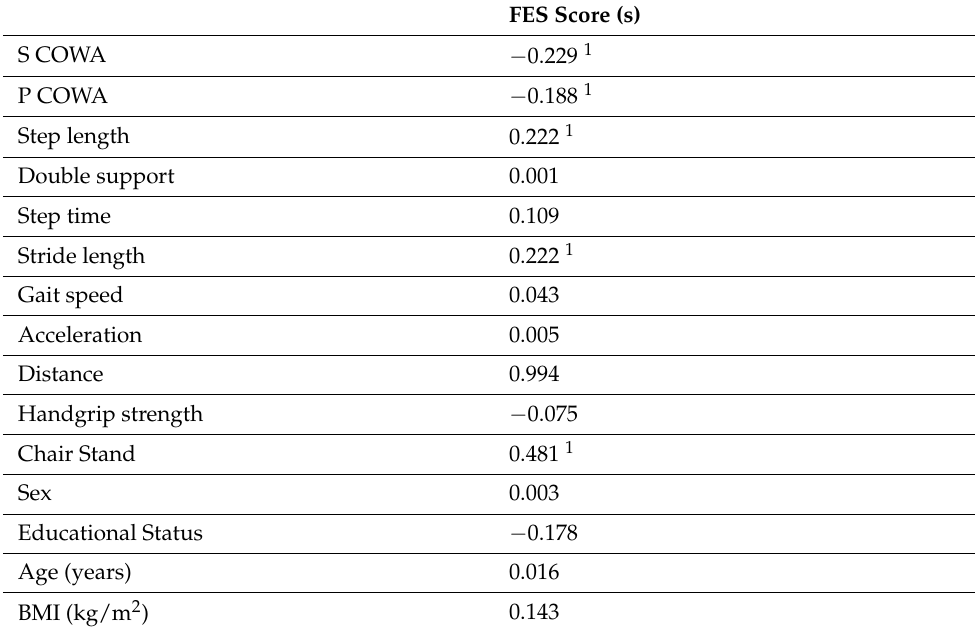
Table 2. Pearson’s correlations between analyzed parameters in this study.